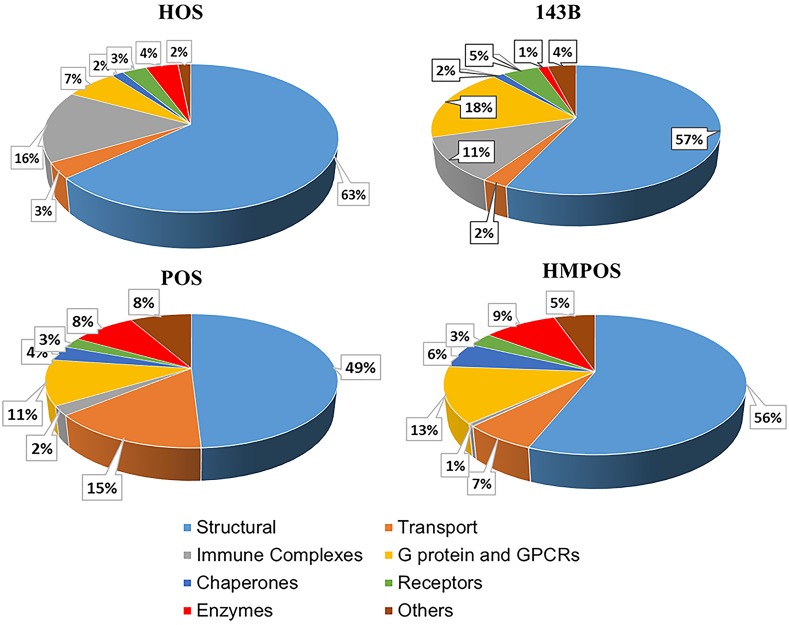
Fig shows global membrane proteomic composition across various cell lines classified according to function.The colors are as mentioned in the key. HOS and POS are the non- metastatic human and canine cell lines and 143B and HMPOS are the metastatic human and canine cell lines respectively.